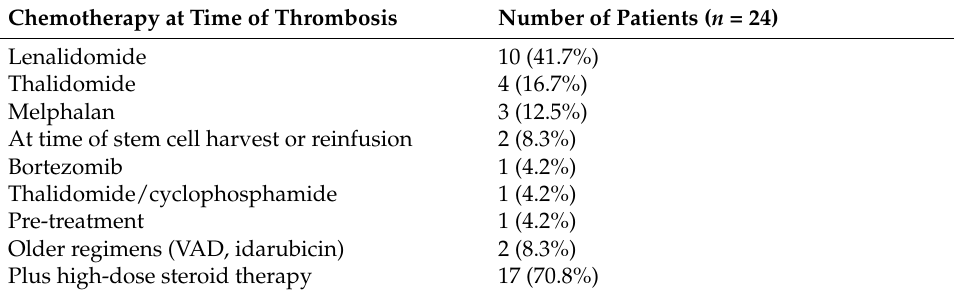
Chemotherapeutic regimens of patients at time of VTE diagnosis. VAD = vin- cristine/doxorubicin/dexamethasone. Chemotherapy at Time of